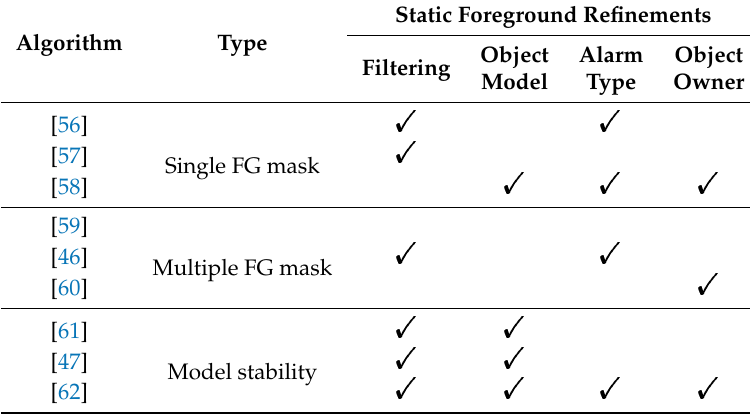
Table 2. Most relevant stationary foreground detection